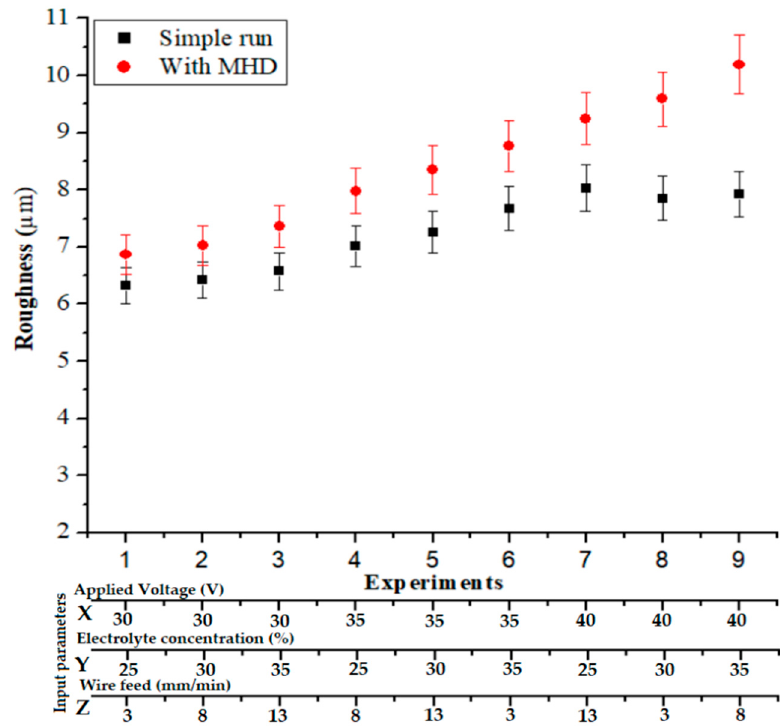
Figure 9. R a ( μ m) with and without using the MHD method. Figure 9. R a ( µ m) with and without using the MHD